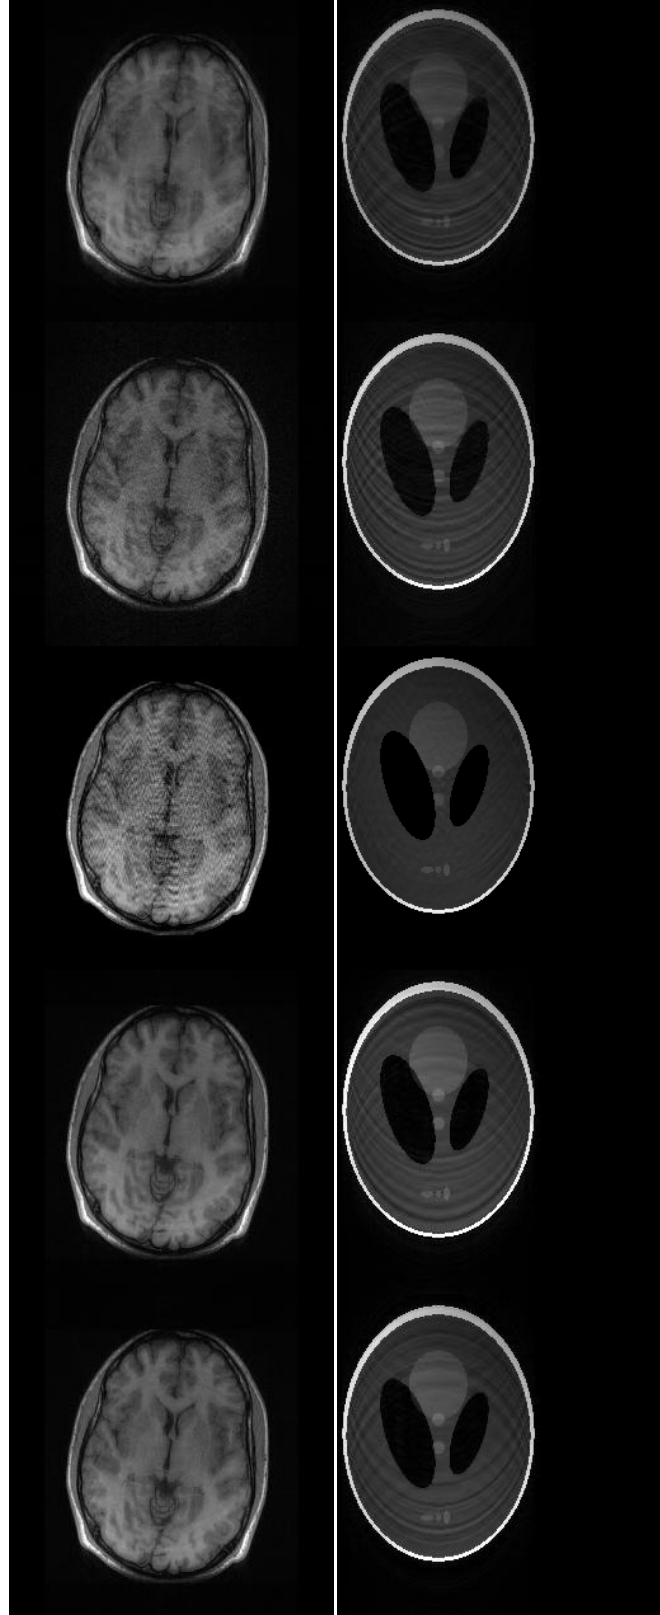
Figure 9. Reconstruction for Variable Density Random sampling. From Top to Bottom: DCS Reconstruction, l1SPIRiT, CS SENSE, SAKE, Proposed Non-Convex Synthesis Prior, Proposed Non-Convex Analysis